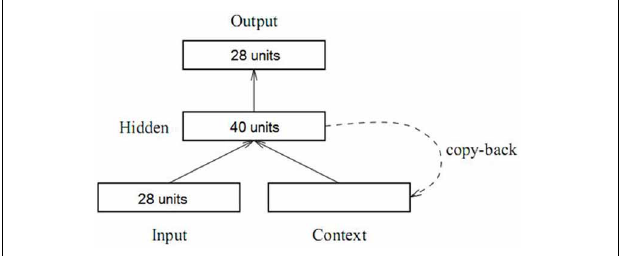
FIGURE 2 | Architecture of the Simple Recurrent Network used in Study